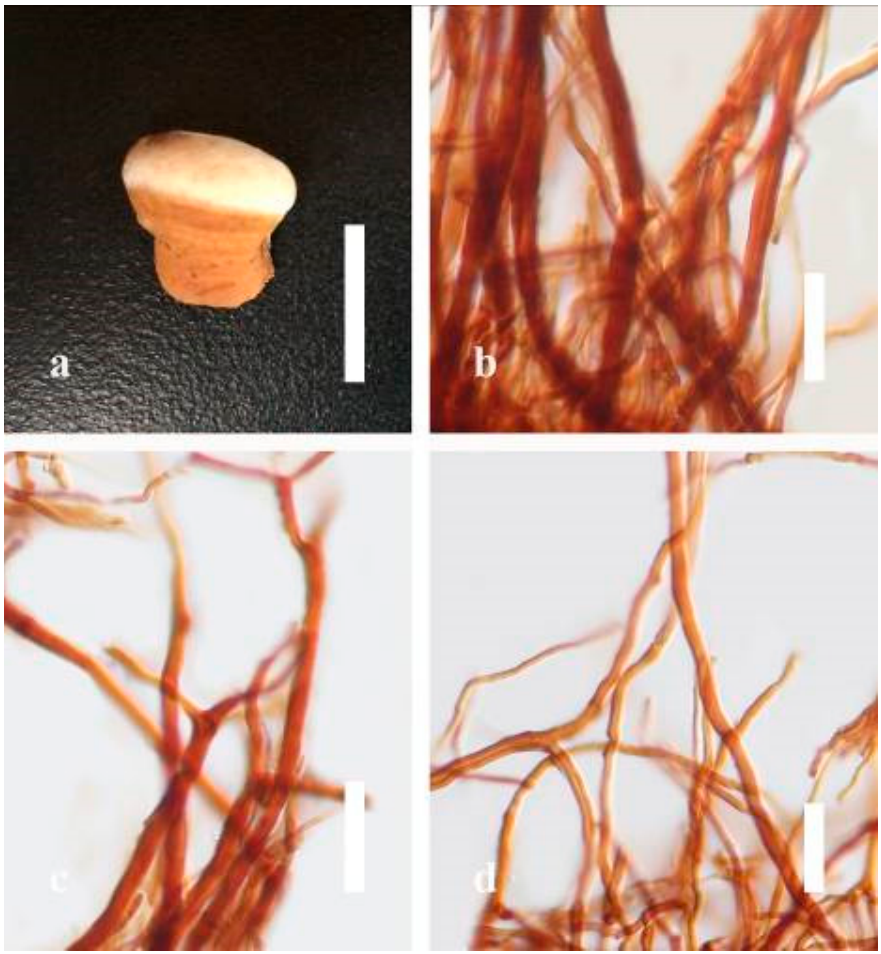
Figure 21. Morphology characteristics of Ganoderma williamsianum (MFLU 19 ‐ 2170): ( a ) young basidiomes; ( b – d ) context hyphae in Melzer’s reagent. Scale bars: ( a ) = 2 cm, ( b – d ) = 20 μ m.